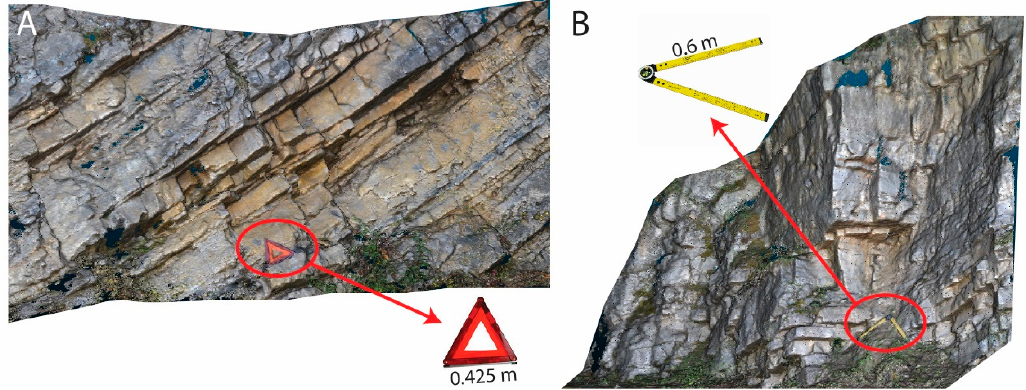
Figure18. Three-dimensionalmodelscreatedusinganemergencywarningtriangle( A )andaruler-angle Figure 18. Three-dimensional models created using an emergency warning triangle ( A ) and a ruler- measure ( B ). angle measure ( B ).